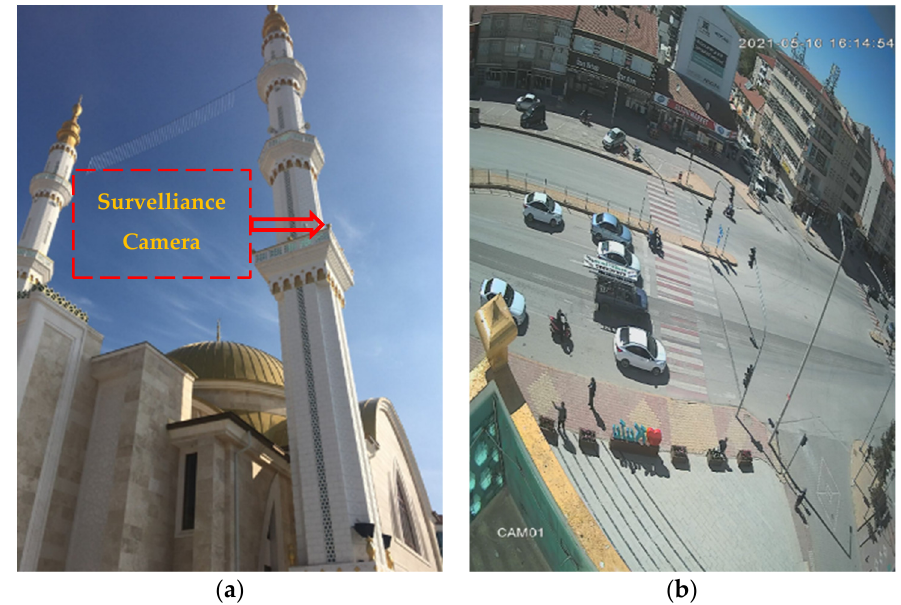
Figure 3. ( a ) Position of the camera placed on the minaret and ( b ) a view from the camera.